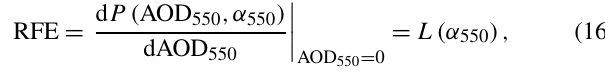
irradiance 1 , S 0 × cos ( SZA ) , where S 0 = 1365 W m − 2 . It